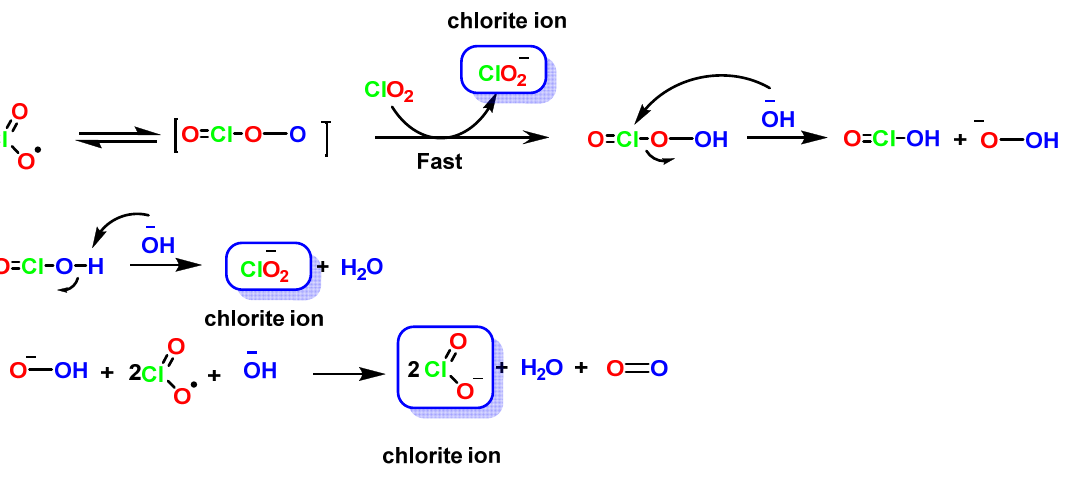
Figure 10. Mechanism of formation of ClO 2 − from ClO 2 in basic medium.